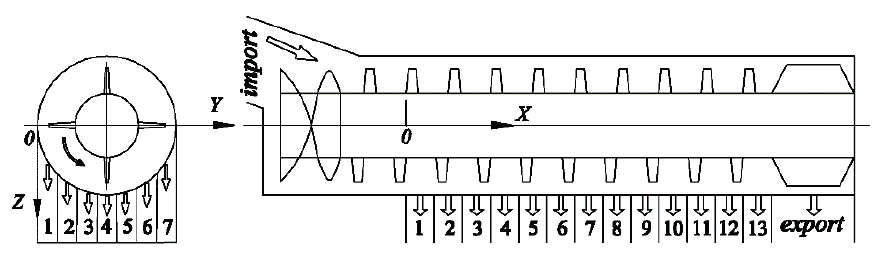
Figure 2. Schematic diagram of coordinate system and location of material’s reception